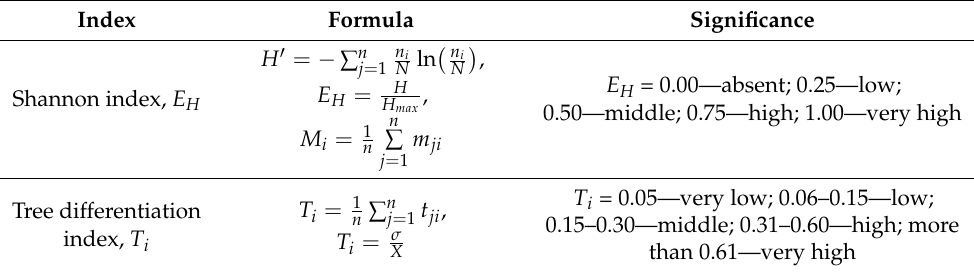
Table 1. Main criterion for the forest species diversity estimation.